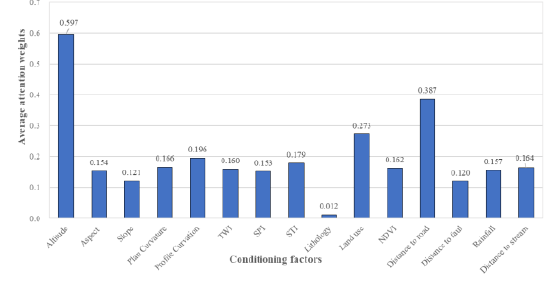
Fig. 9. The average attention weights of the contributing